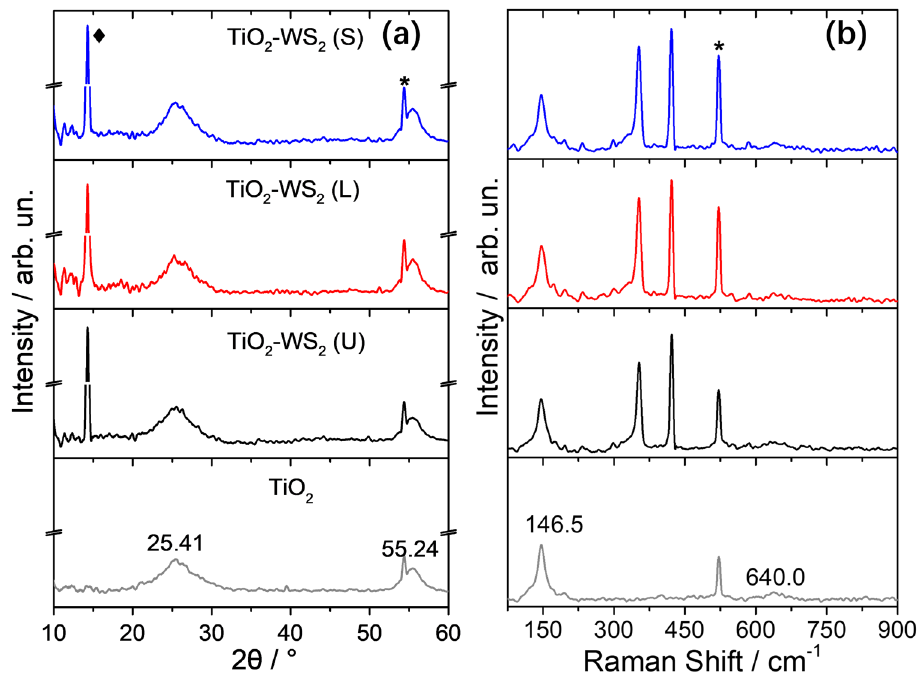
Figure 5. ( a ) XRD patterns and ( b ) Raman spectra of WS 2 -TiO 2 films: undoped TiO 2 (grey line), TiO 2 -WS 2 -U (black line), TiO 2 -WS 2 -L (red line), and TiO 2 -WS 2 -S (blue line). The signal at 521.5 cm − 1 , marked with an asterisk, is caused by the monocrystalline Si wafer.